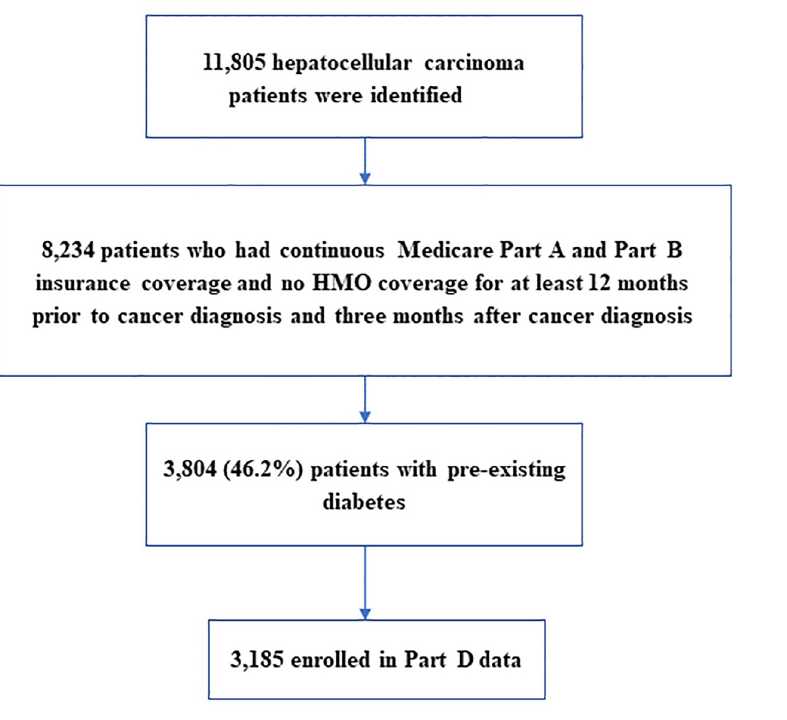
Fig 1. Study population flow